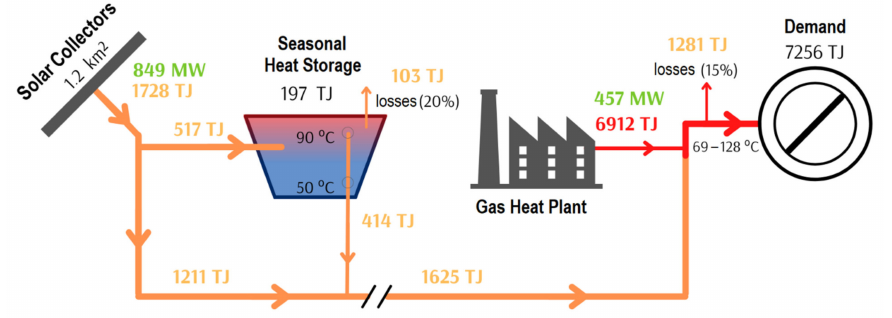
Figure 1. Schematic diagram of the tested system and energy balance for the STAT scenario with the share of RES in heat production amounting to